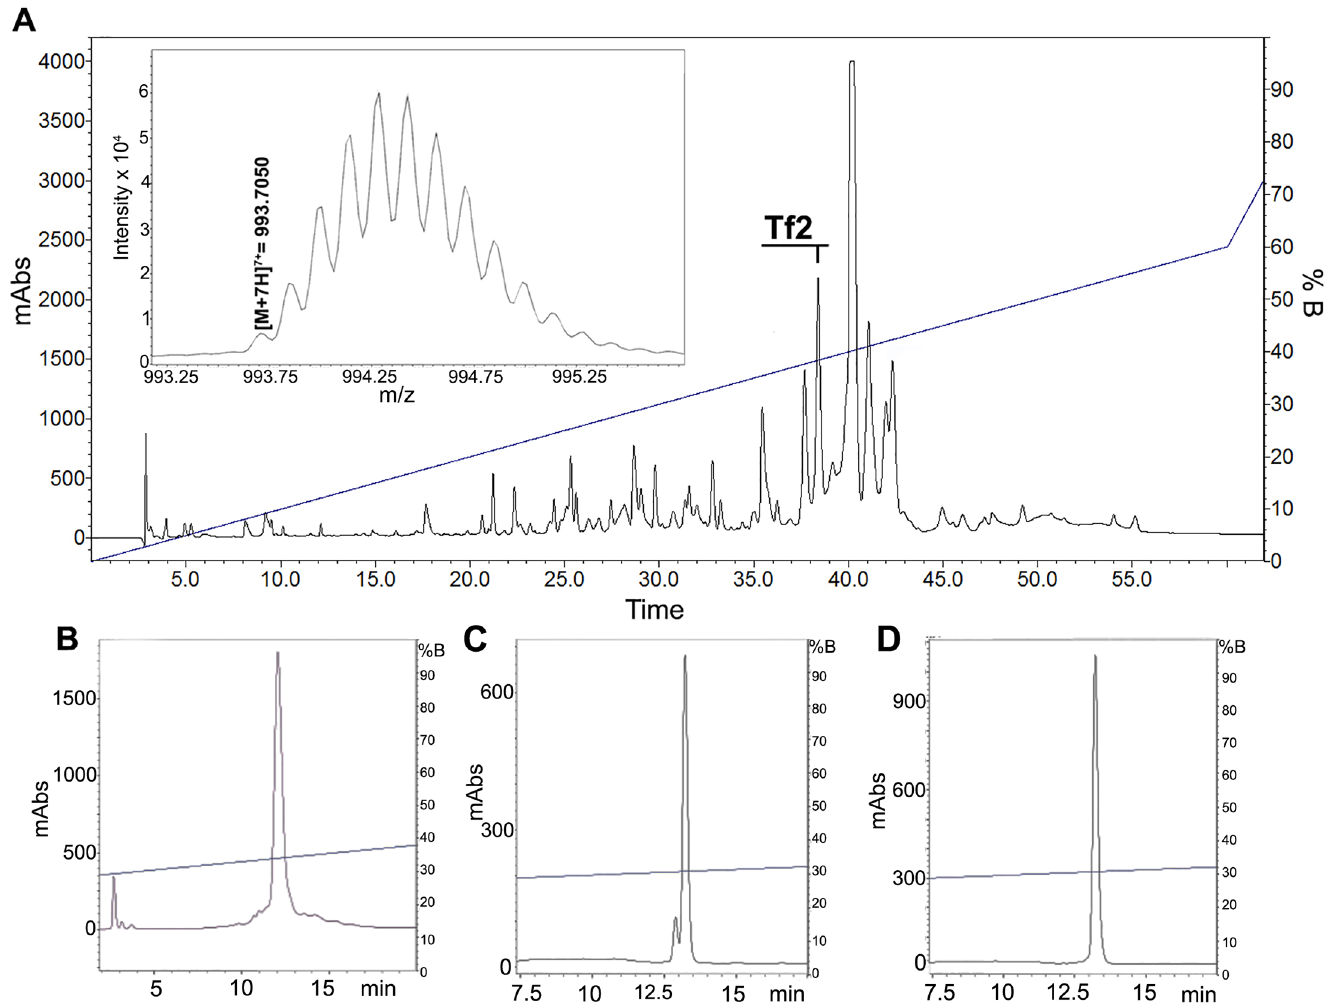
Fig 1. Purification and molecular mass determination of Tf2. (A) Chromatography by RP-HPLC of 1 mg of T . fasciolatus crude venom. Fractionation was performed on a C18 analytical column, using a linear gradient from 0% solvent A (0.12% TFA in water) to 60% solvent B (0.10% TFA in acetonitrile) over 60 min at a flow rate of 1 mL/min, with detection at a wavelength of 216 and 280nm. The component eluted at 38.5% of acetonitrile corresponds to Tf2. (B-D) Three additional chromatographic protocols performed to obtain pure Tf2. (B) Linear gradient of B solvent, from 25 to 45% B in 40 minutes, at room temperature (22°C). (C) Linear gradient of B solvent, from 25 to 45% of B in 40 minutes, at 45°C. (D) Linear gradient of B solvent, from 30 to 40% of B in 40 minutes, at 45°C. Inset on (A) shows mass spectrometry analysis of Tf2 by micrOTOF-Q II, presenting the monoisotopic distribution of the +7 charged ion ([M +7H] 7+ = 993.7050), which is equivalent to [M+H] + 6949.9350